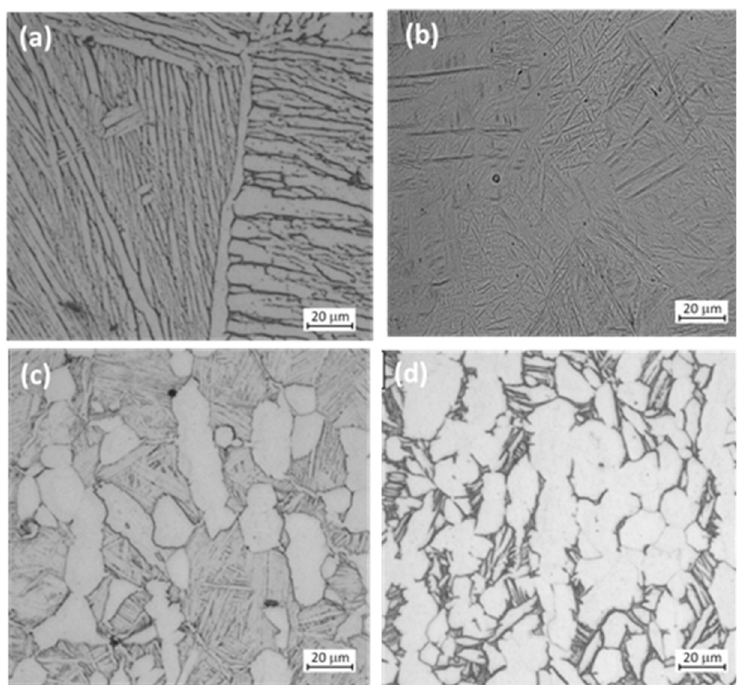
Figure 2. Microstructure of Ti-6Al-4V alloy. ( a ) Lamellar, ( b ) martensitic, ( c ) bimodal microstructure with alpha grains (white) and transformed microstructure into prior β grain, and ( d ) equiaxed alpha grains (white) and intergranular beta at the alpha grain boundary. Panels ( a , c , d ) reproduced under the Creative Commons Attribution License from [33].